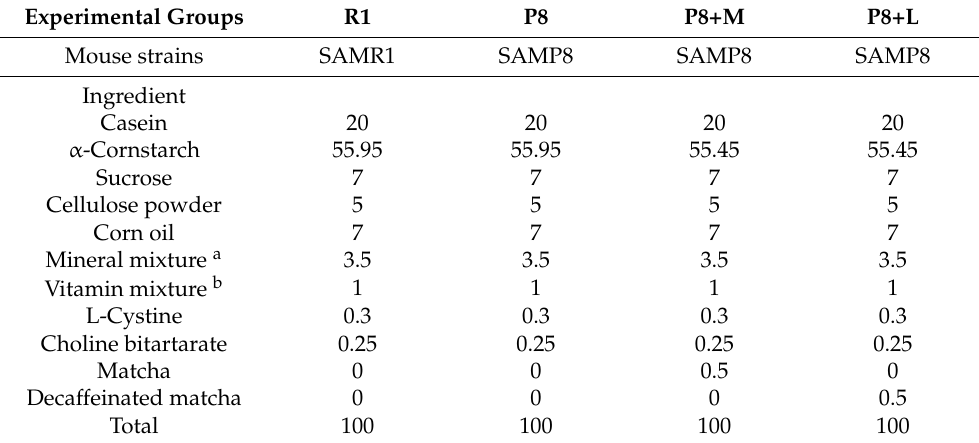
Table 1. Composition of diets (%). Experimental